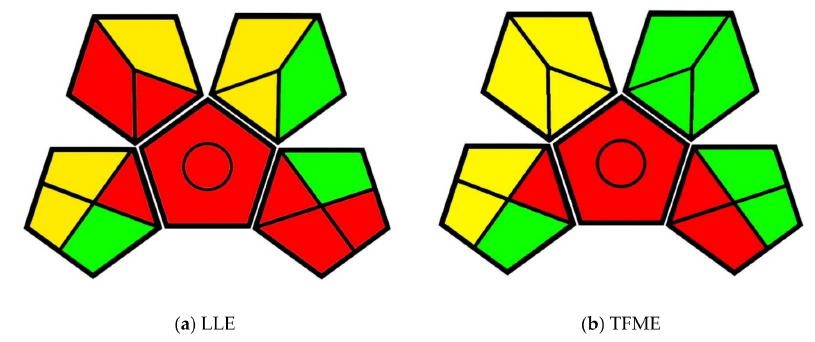
Figure 3. ( a ) GAPI evaluation pictogram for the liquid–liquid extraction (LLE) method; ( b ) GAPI evaluation pictogram for the thin-film microextraction (TFME) method in Piri-Moghadam et al., 2017